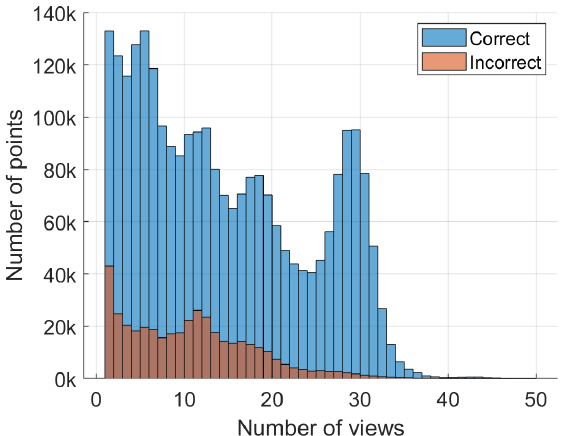
Figure 7. Counts of correctly and incorrectly classified points as functions of the number of views from which they are visible.